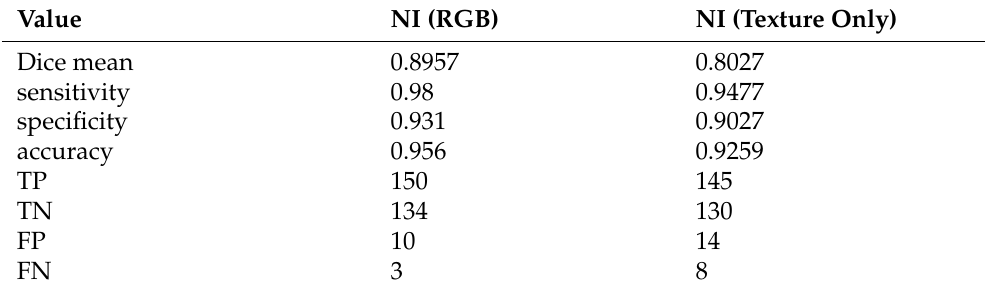
Table 4. Nickel material segmentation results.